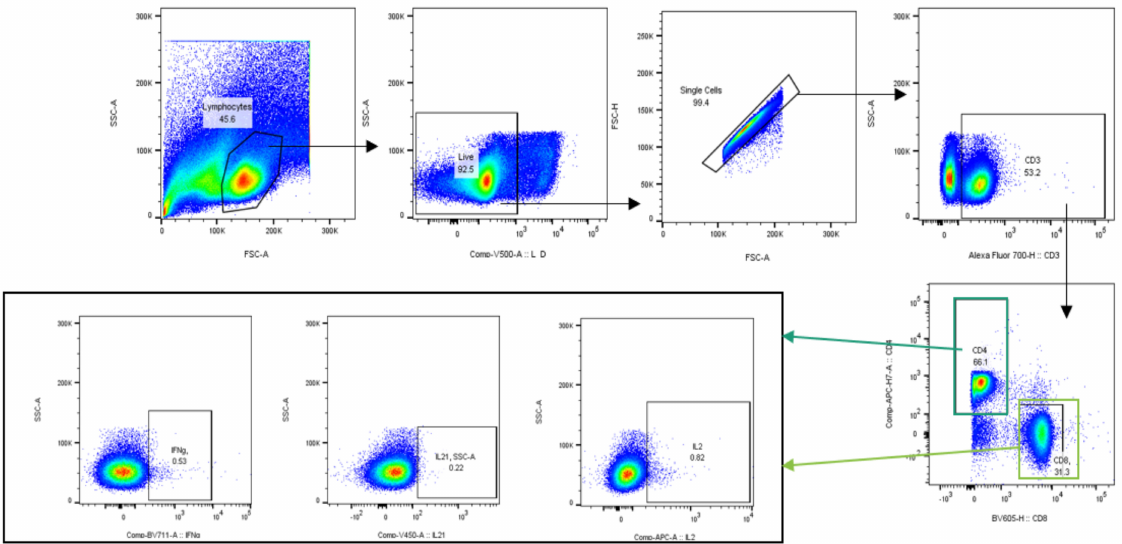
Figure A3. Gating strategy for mice splenocytes. Lymphocytes were gated among the splenocyte population, and alive, then single cells were selected. CD3 + cells were gated, and CD4 + or CD8 + cells isolated. Among CD4 + and CD8 + , respectively, cytokine secretion (IL-2, IL-21 and IFN- γ ) were characterized.